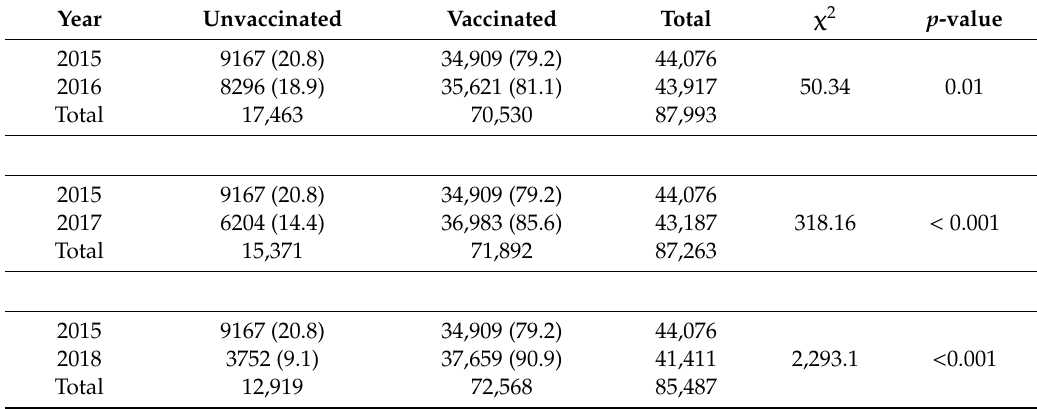
Table 6. Percentage of vaccinated and unvaccinated children in the Sicily region in 2015 and comparisons with the following